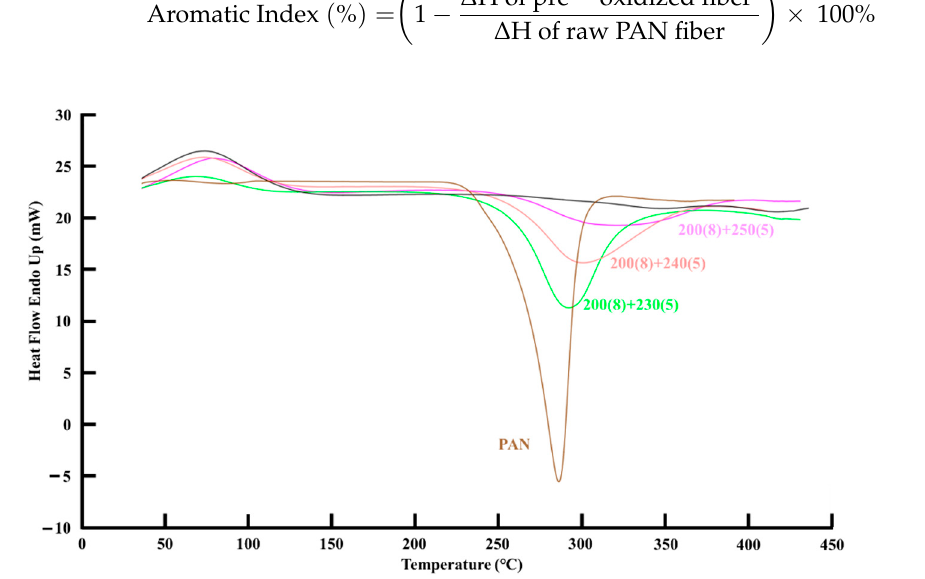
Figure 8. The DSC results for the specimens of the two-step microwave annealing process. Table 2. The aromatic index of specimens under several processing conditions from DSC results.